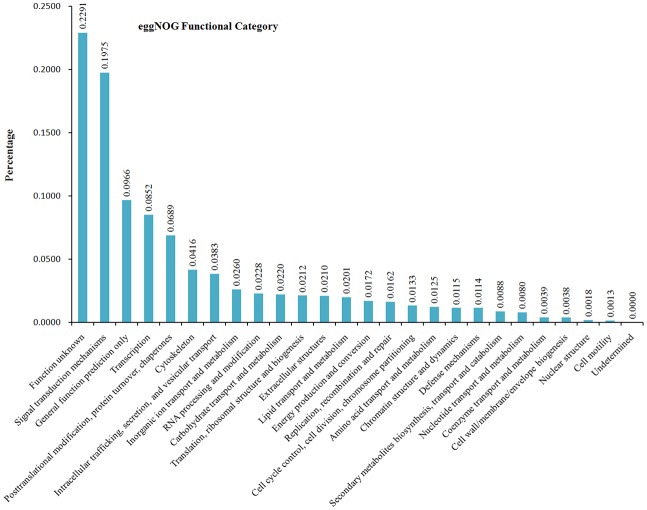
eggNOG functional categories.